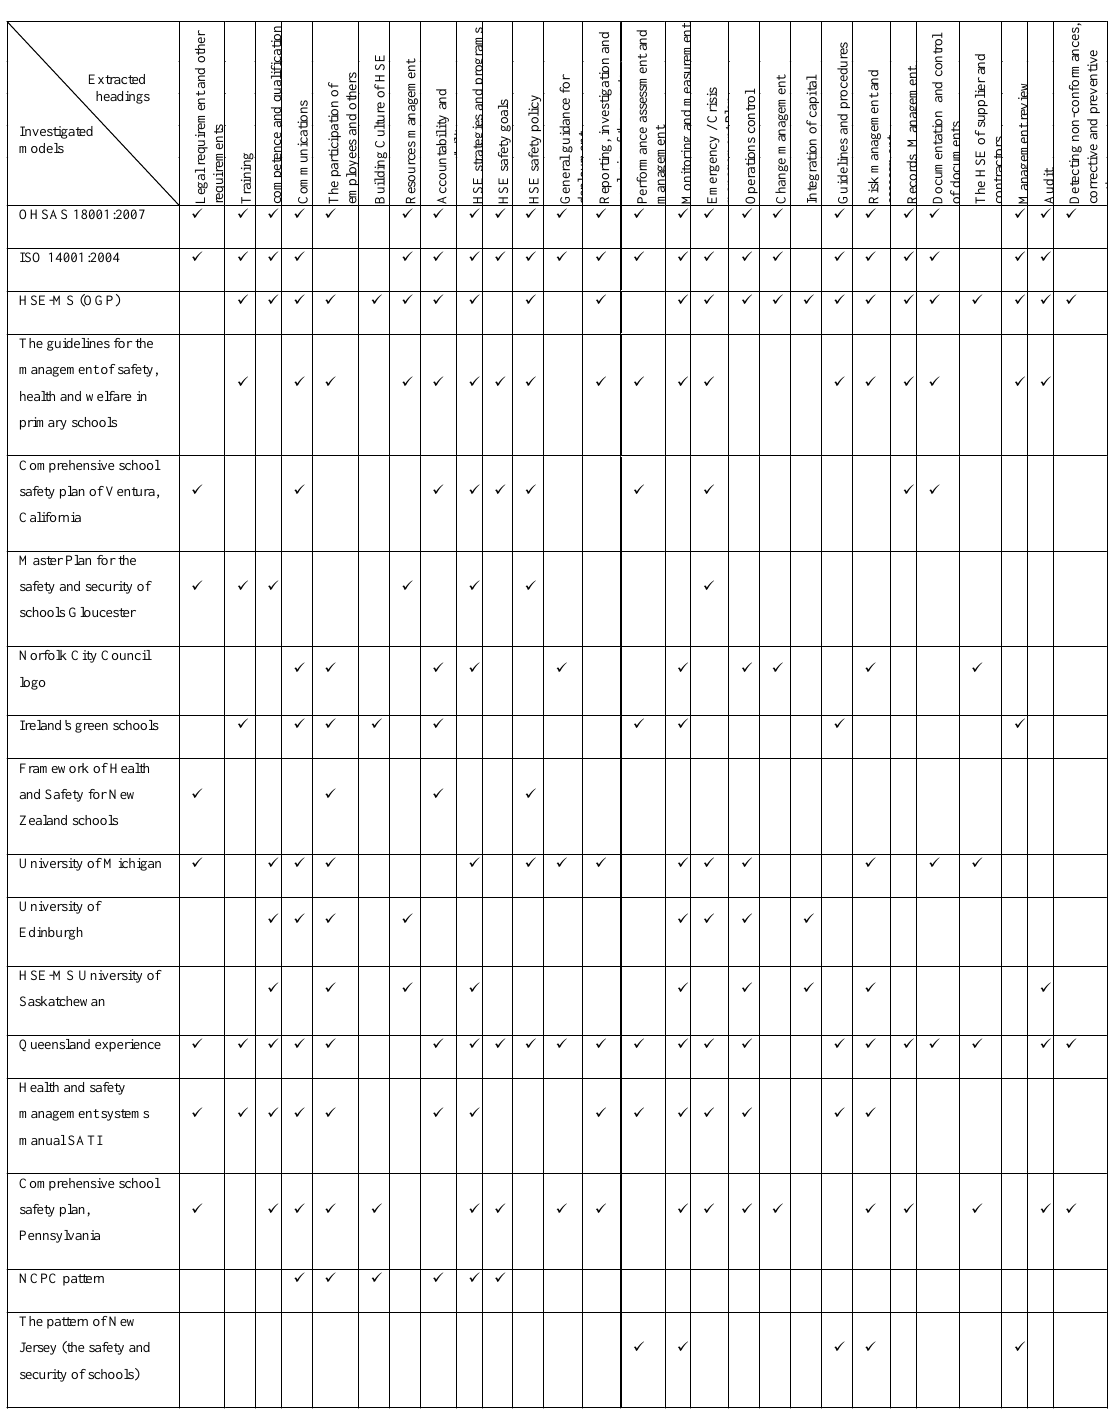
Table1: Checking the extracted headings in each studied model